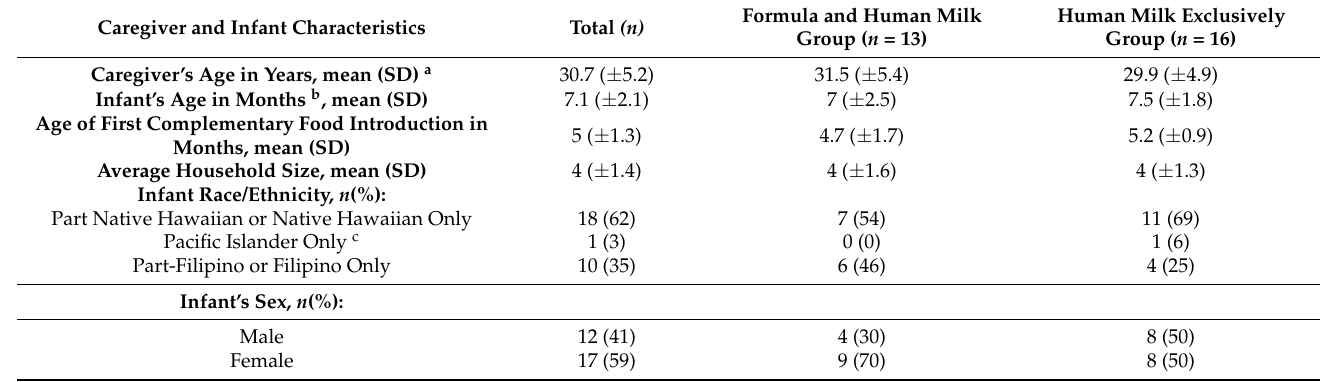
Table 1. Demographic characteristics relating to the caregivers and the 29 Native Hawaiian and Other Pacific Islander and Filipino infants who participated in in-depth interviews relating to complemen- tary